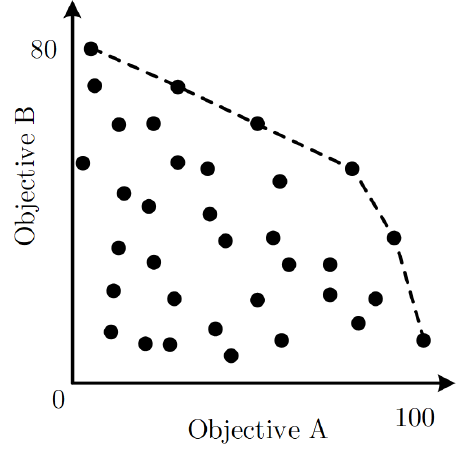
Figure 6. Pareto front for two objectives